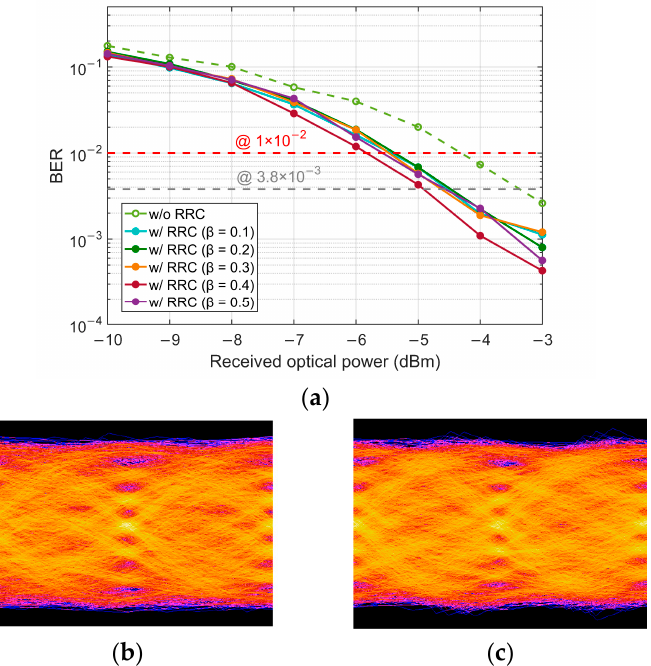
Figure 3. ( a ) BER of different roll-off factors of RRC filter under the case of BtB and without SOA; Eye diagrams of without RRC ( b ), and with RRC ( c ) with a roll-off factor of 0.4.